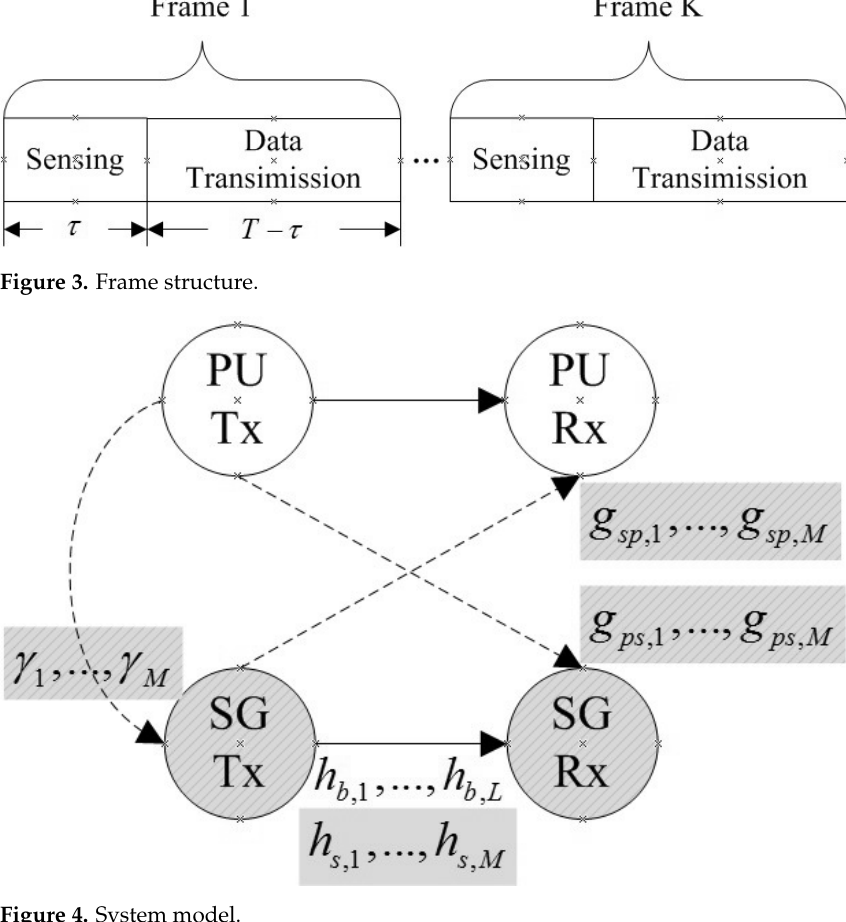
Figure 4. System